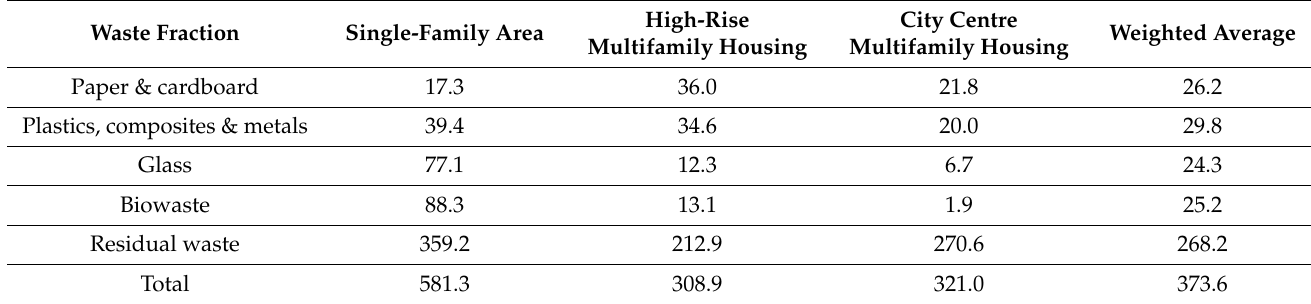
Table 2. Individual waste collection rates for different types of housing [kg per capita and year].